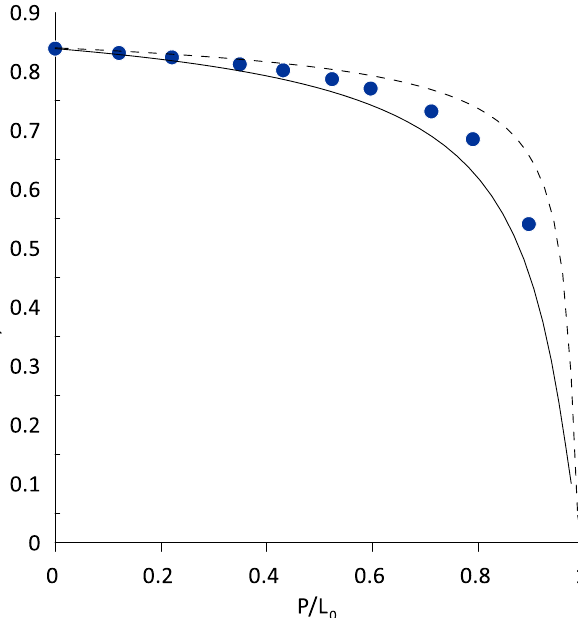
Figure 6. Curves of residual concentrations for the ethanol–water–AEPA-DEG mixture at [AEPA- DEG] = 20 wt.% (geometric figures are experimental data, continuous line is calculated data). Dashed lines are calculated data for the ethanol–water mixture.